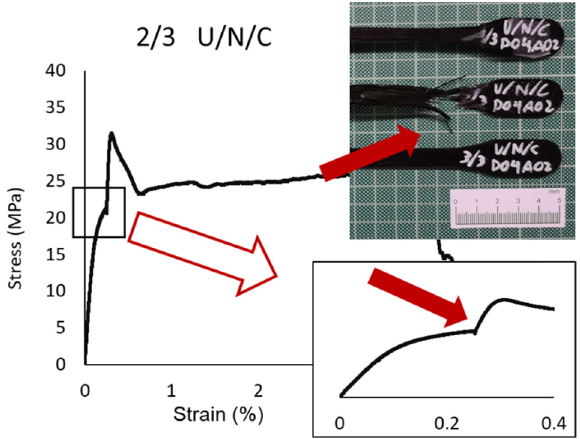
Figure 11. Initial tear on U/N/C sample and its representation on stress-strain